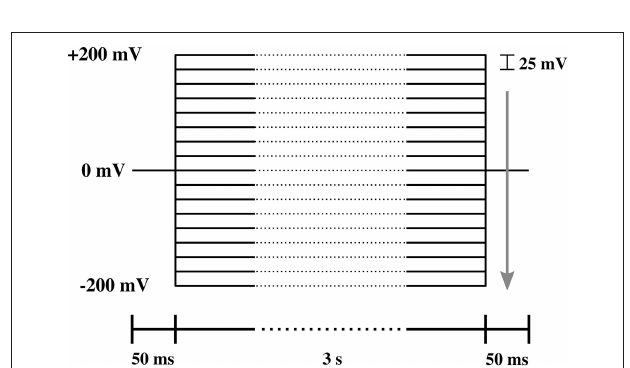
FIGURE 3 | Protocol of the voltage steps used in the I-V measurement. The lower bar indicates the duration of each part of the protocol. The arrow shows the direction of voltage steps, which ranged from 200 to − 200 mV in steps of − 25